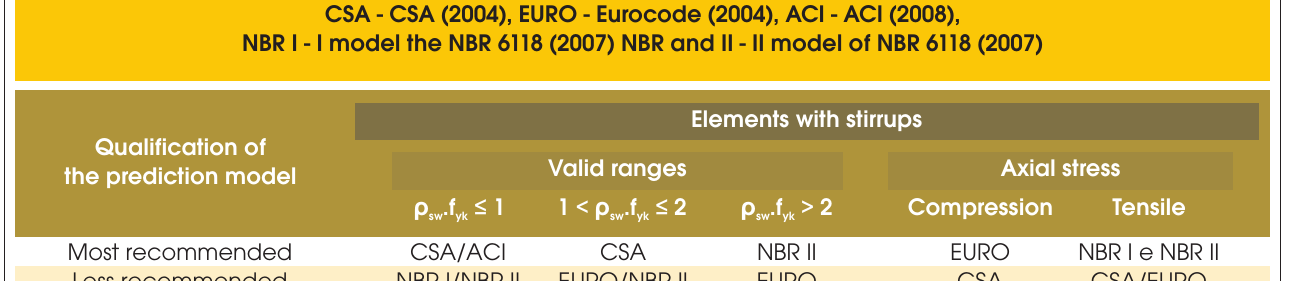
Table 9 – Prediction models recommended and less recommended for analysis of elements with stirrups,